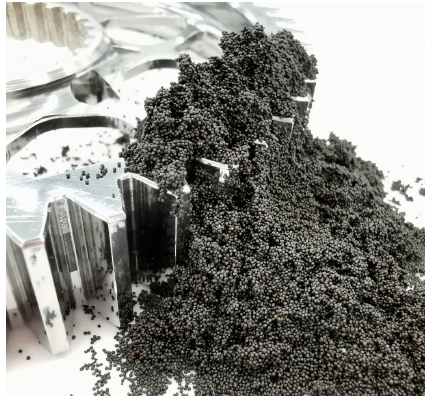
Figure 7. Medium size versus gear teeth module [17].